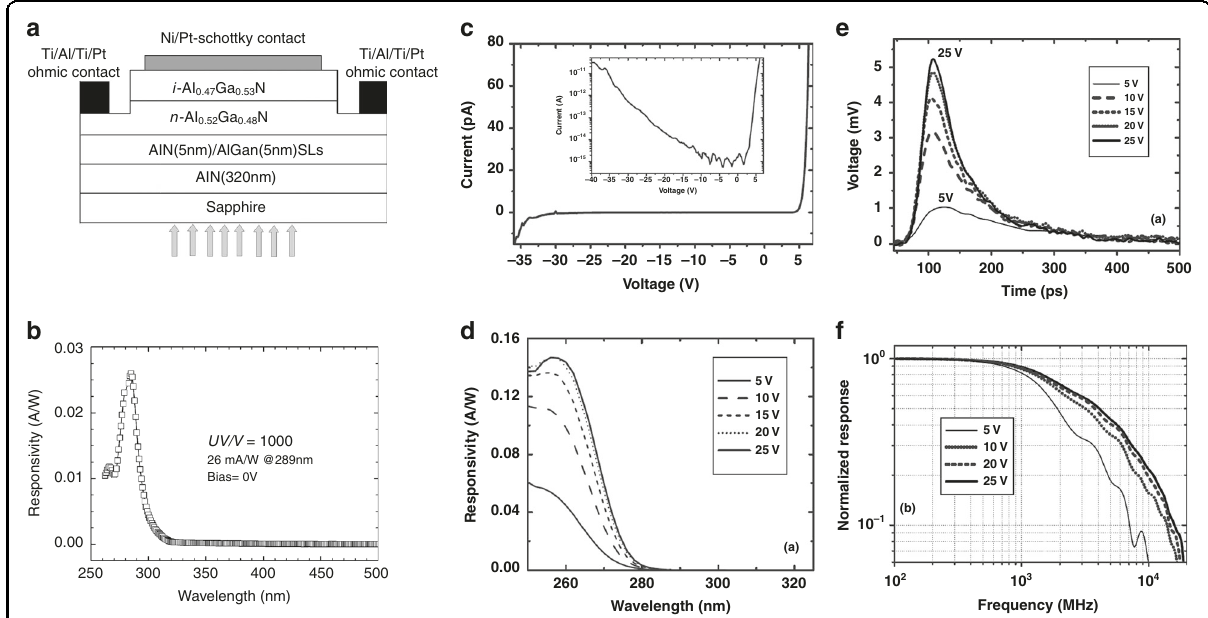
Fig. 10 Structure and performance of AlGaN Schottky barrier photodiodes. a Schematic structure of Schottky AlGaN photodetector. b Responsivity of the fabricated device at 0 V. Reprinted with permission from Sang et al. 166 . Copyright 2008 Chinese Physical Society and IOP Publishing Ltd. c Dark current of the fabricated AlGaN photodetector. d Responsivity of the devices at different applied voltages. e Pulse response of the devices at different applied voltages. f Corresponding fast Fourier transform curves. Reprinted with permission from Tut et al. 169 . Copyright